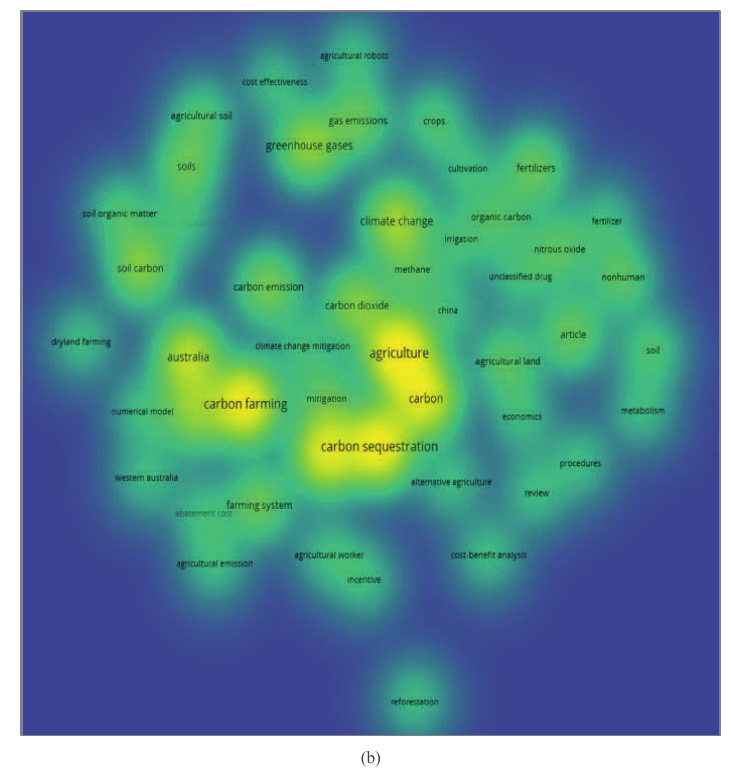
Fig. 1. (a) Network visualization; (b) Density